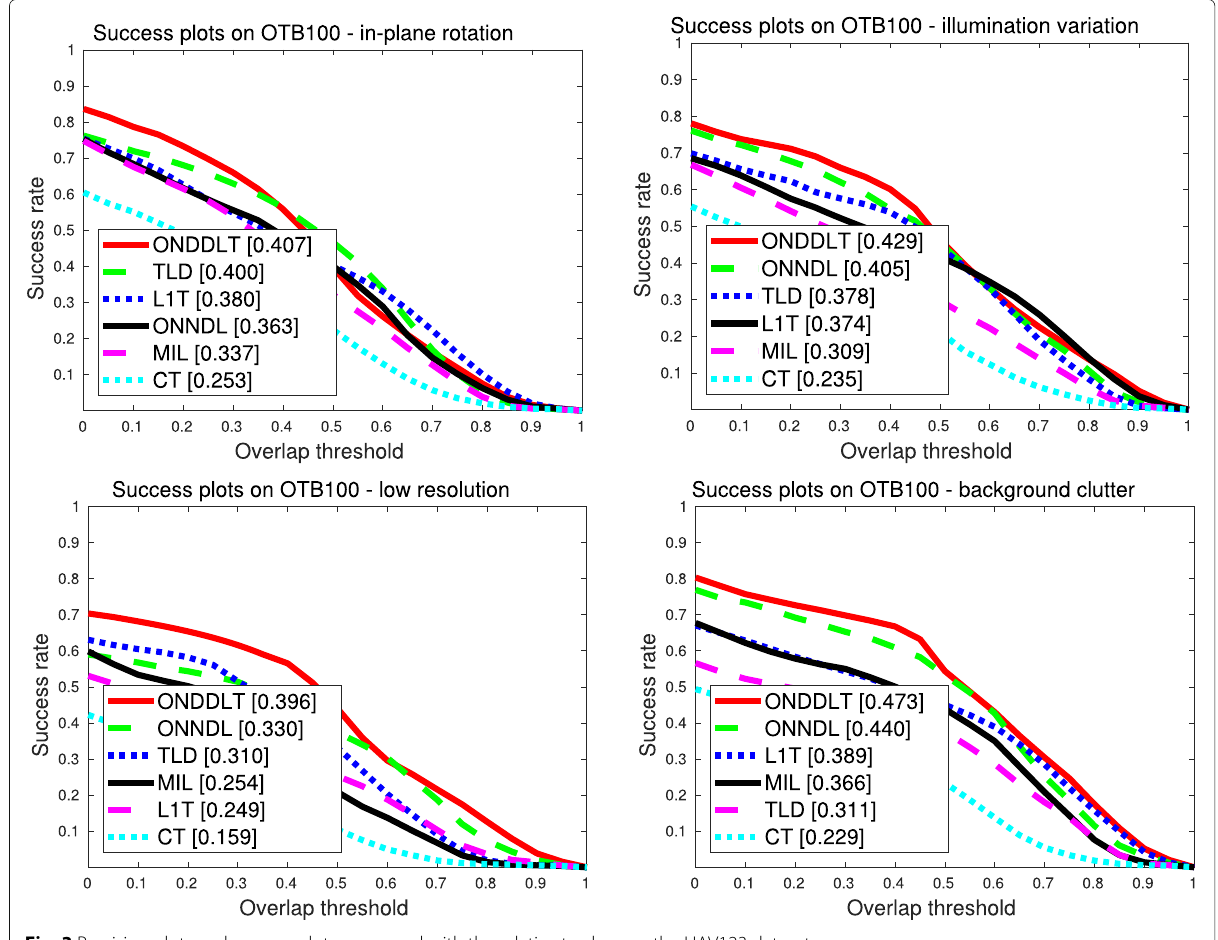
Fig. 3 Precision plots and success plots compared with the relative trackers on the UAV123 dataset